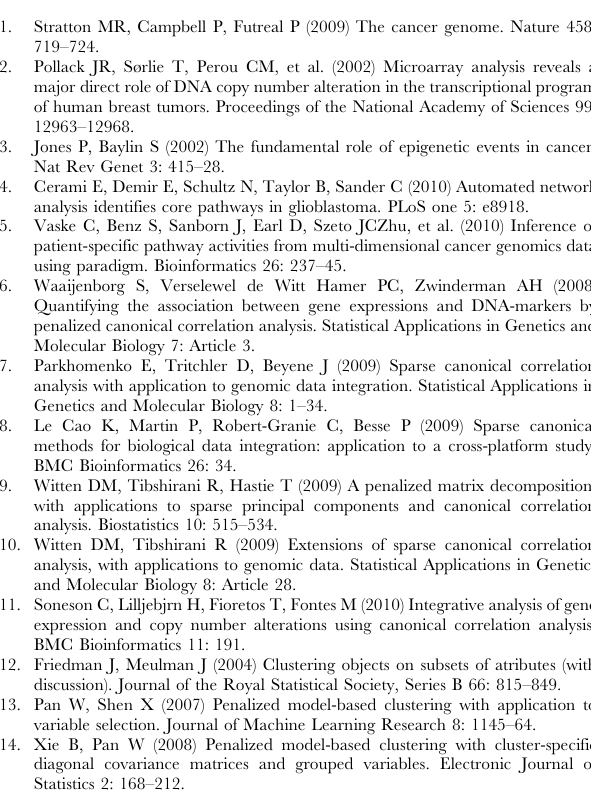
Table S1 Selected methylation features and functional annotations using DAVID. Table S2 Selected expression features and functional annotations using